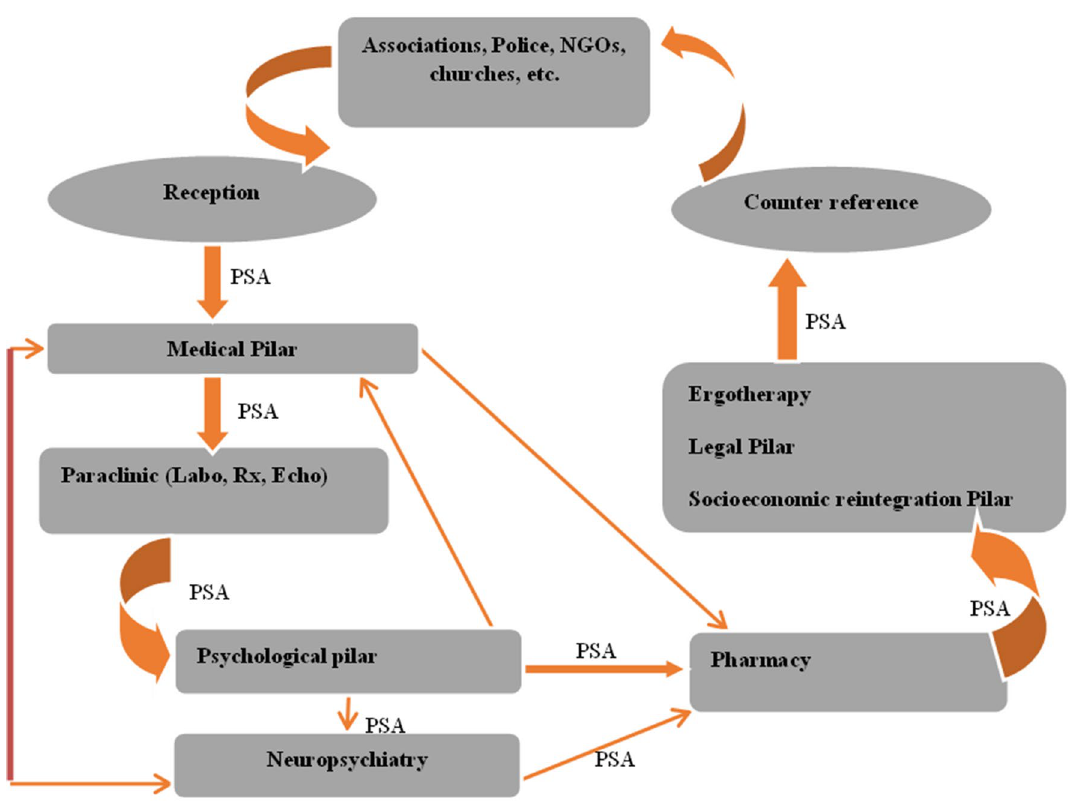
Fig. 1 Panzi Model for Holistic